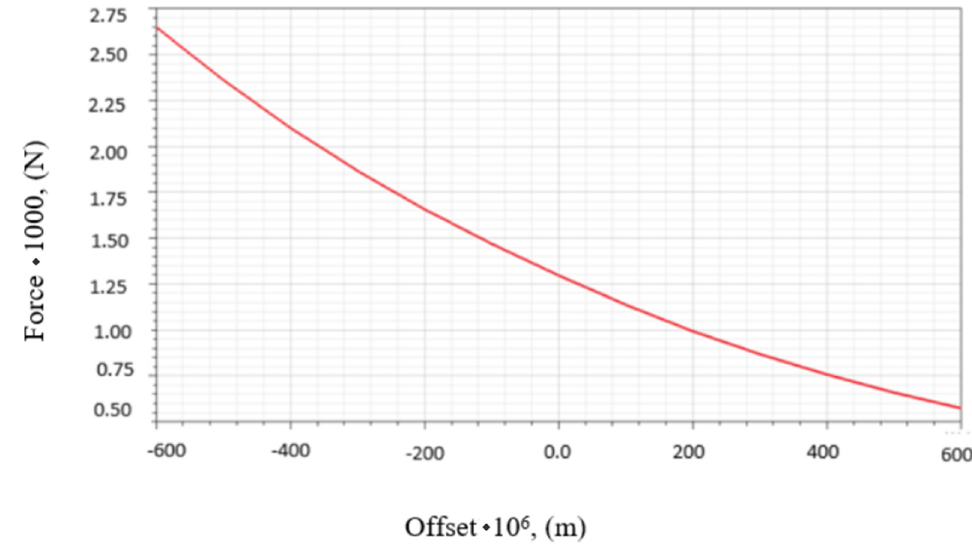
Figure 12. The dependence of the bearing capacity of a magnetic bearing on the current at zero Figure 11. The dependence of the bearing capacity of a magnetic bearing on the displacement at a current of 40 A.